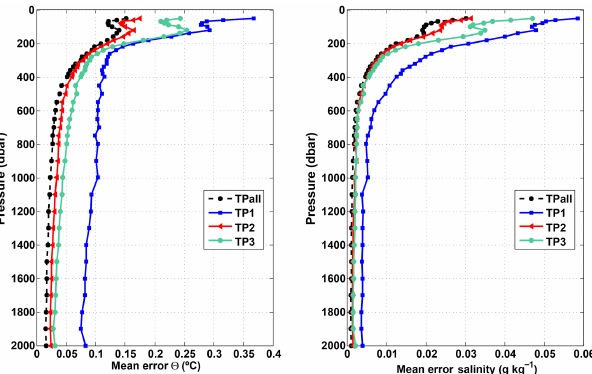
Figure 13. The vertical pressure profile of the area-weighted mean mapping error for (a) conservative temperature ( ◦ C) and (b) ab- solute salinity (gkg − 1 ); for the entire time period (black circles, dashed line), as well as TP1, TP2 and TP3 (the blue squares, red triangles and green circles